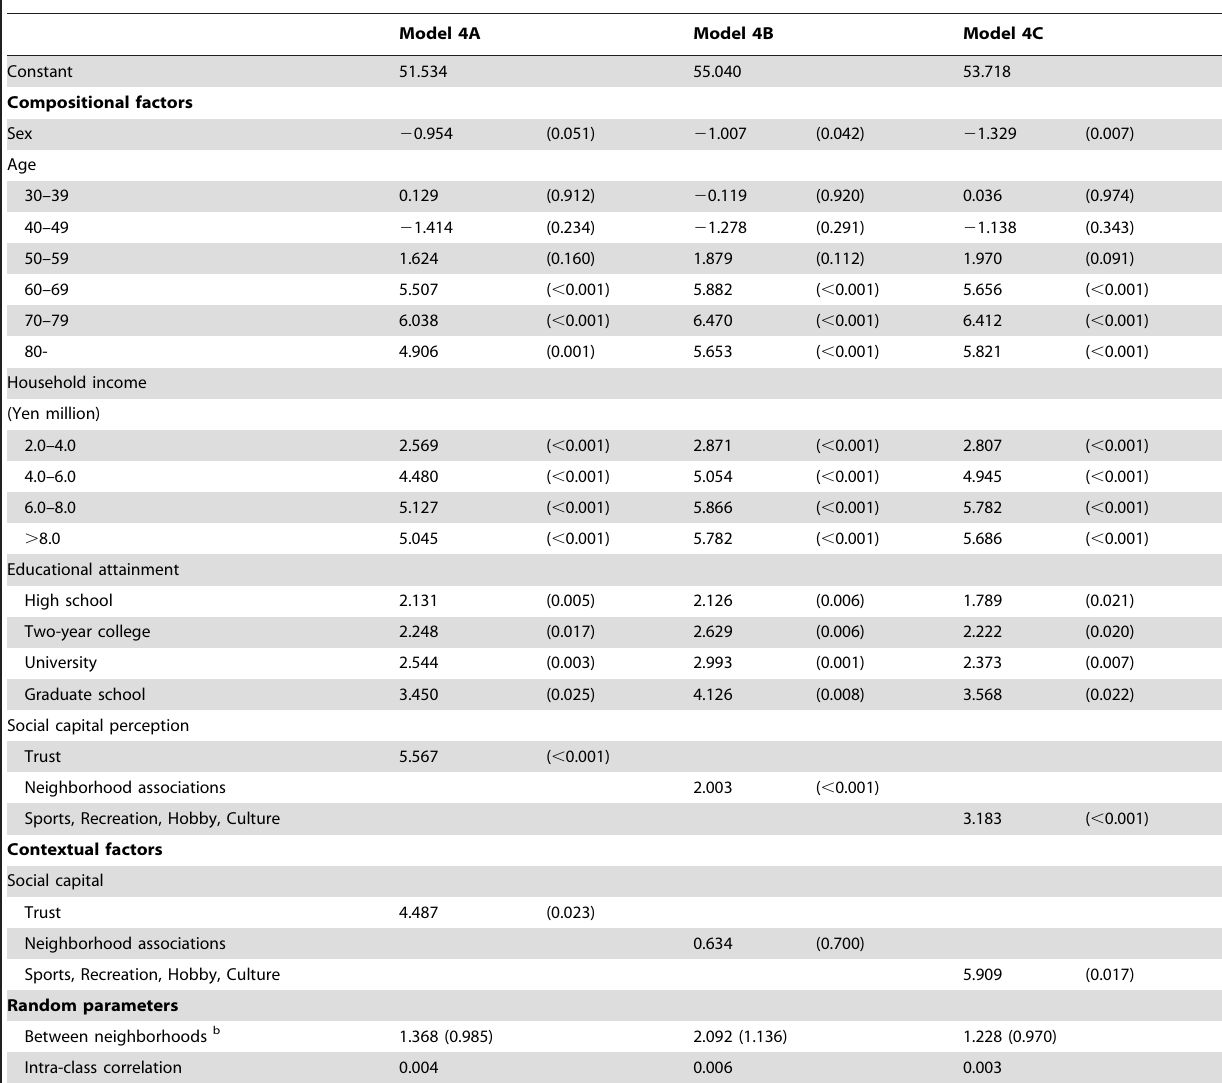
Table 3. Fixed and random part results for the multilevel analytical models.